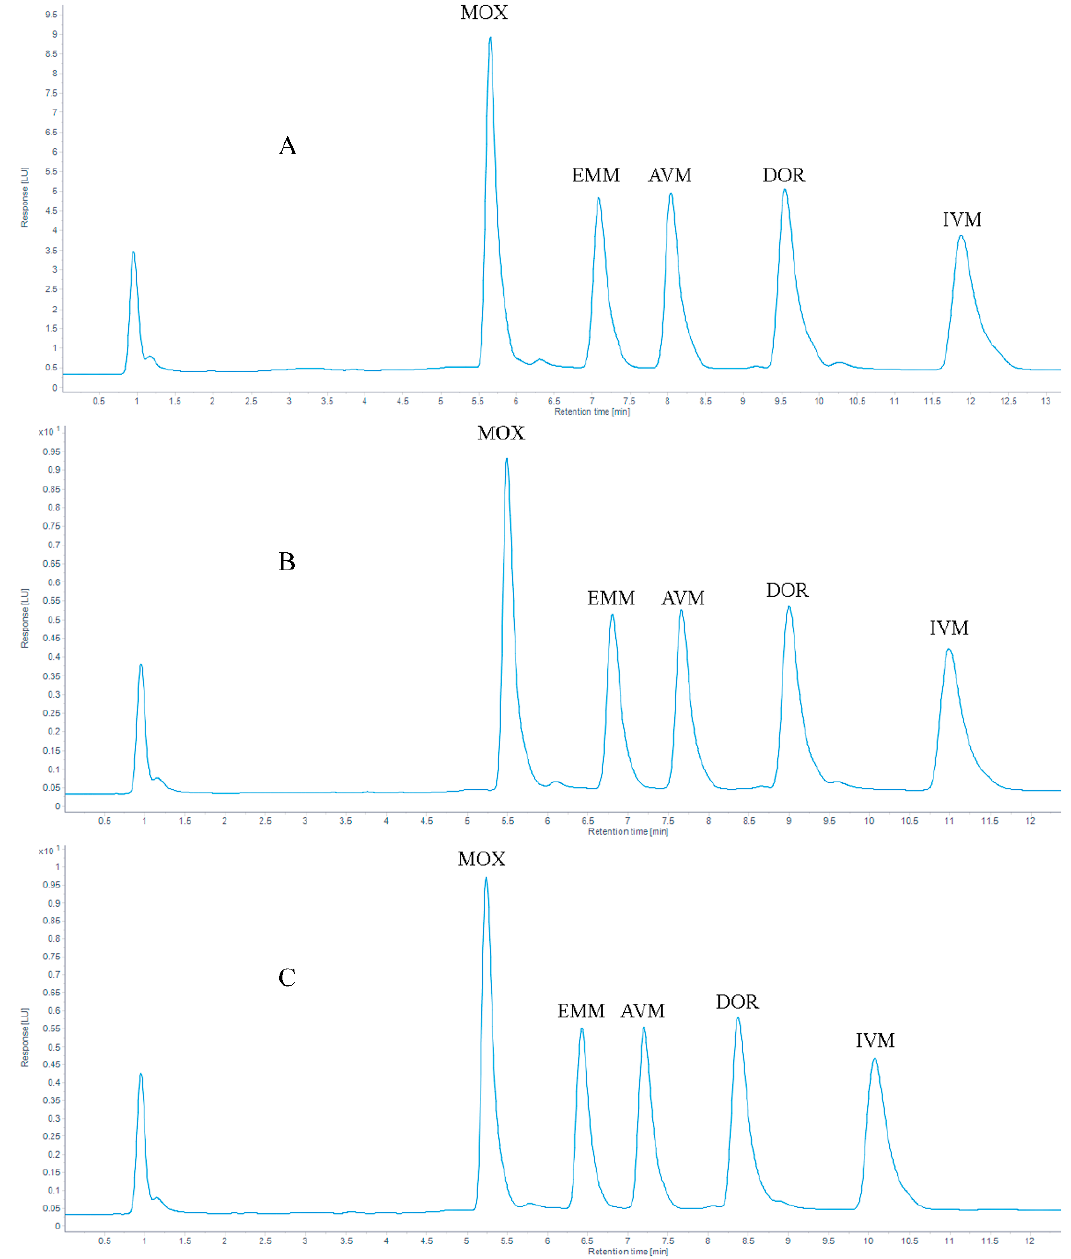
Figure 2. Chromatogram of 100 μ g/kg AVMs standards at ( A ) 30 °C, ( B ) 35 °C and ( C ) 40 °C. Table 2. The retention time of 100 μ g/kg AVMs standard at 30 ℃ , 35 ℃ and 40 ℃ .